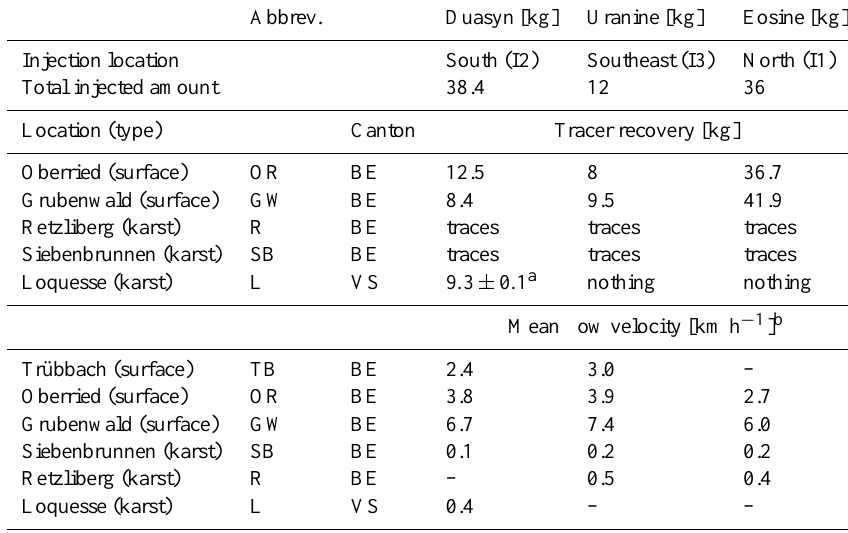
Table 3. Overview of tracer recovery in karst and surface runoffs after the injections in August 2011.